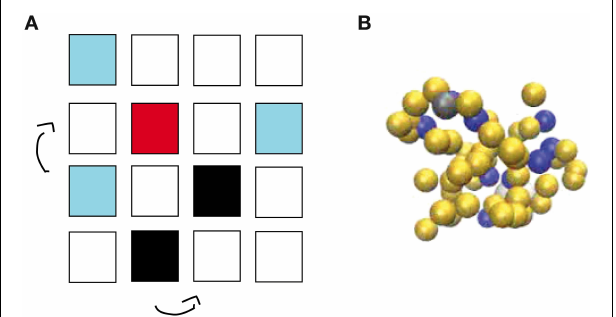
FIGURE 1 | Simulation methods used in this work. (A) Schematic view of the lattice implementation, in which L ligands (light blue) and C crowders (black) diffuse by hopping to one of the six nearest neighbor lattice sites until a ligand finds a target (red). Molecules have square geometry and diffusion is only allowed if the site of destination is unoccupied. Note that the simulations use a three-dimensional lattice rather than the two-dimensional one depicted schematically here. (B) Snapshot from the off-lattice simulation package ReaDDy. L ligands (dark blue), a single target (gray) and C crowders (yellow) diffuse and react in a simulation box with volume V